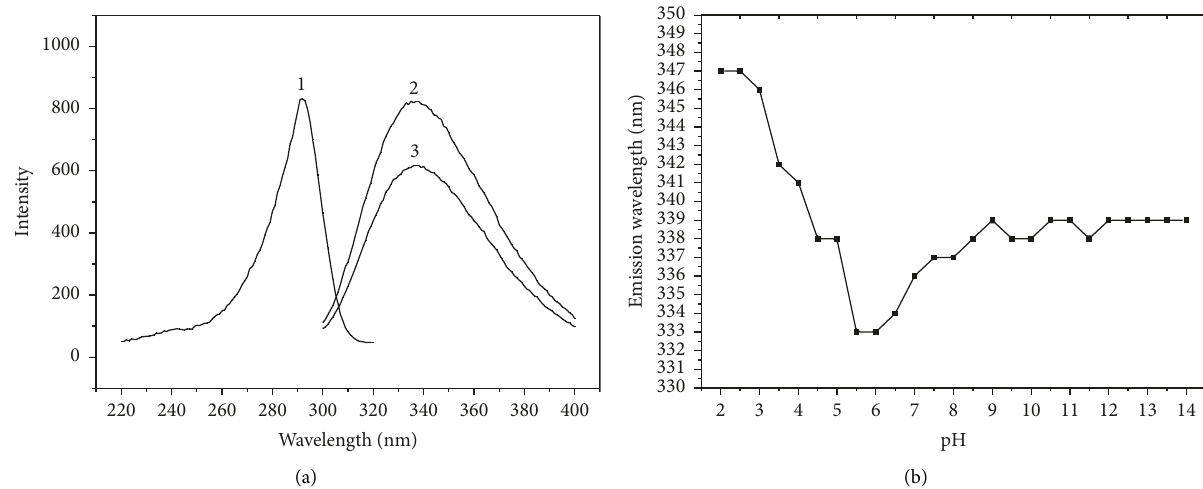
Figure 5: (a) Fluorescence spectra of native LML: curve 1 is excitation spectrum at emission wavelength of 337nm; curves 2 and 3 are emission spectra at excitation wavelengths of 280nm and 292nm, respectively. Slit width of emission and excitation was 5nm; and (b) the change of emission spectra peak using the excitation wavelength of 292nm and the slit width of emission and excitation was 5nm.